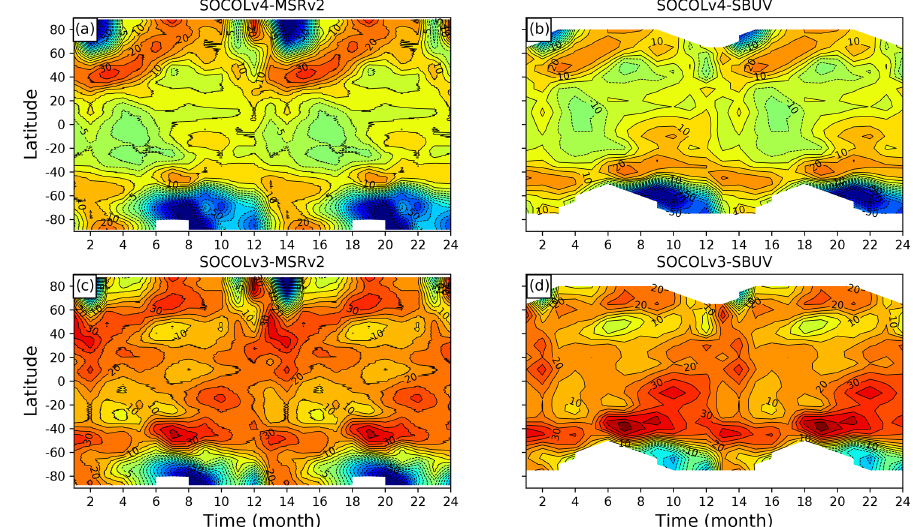
Figure A4. Mean seasonal cycle differences between the total ozone column simulated by SOCOLv4 and SOCOLv3 and estimated by MSRv2 reanalysis and SBUV